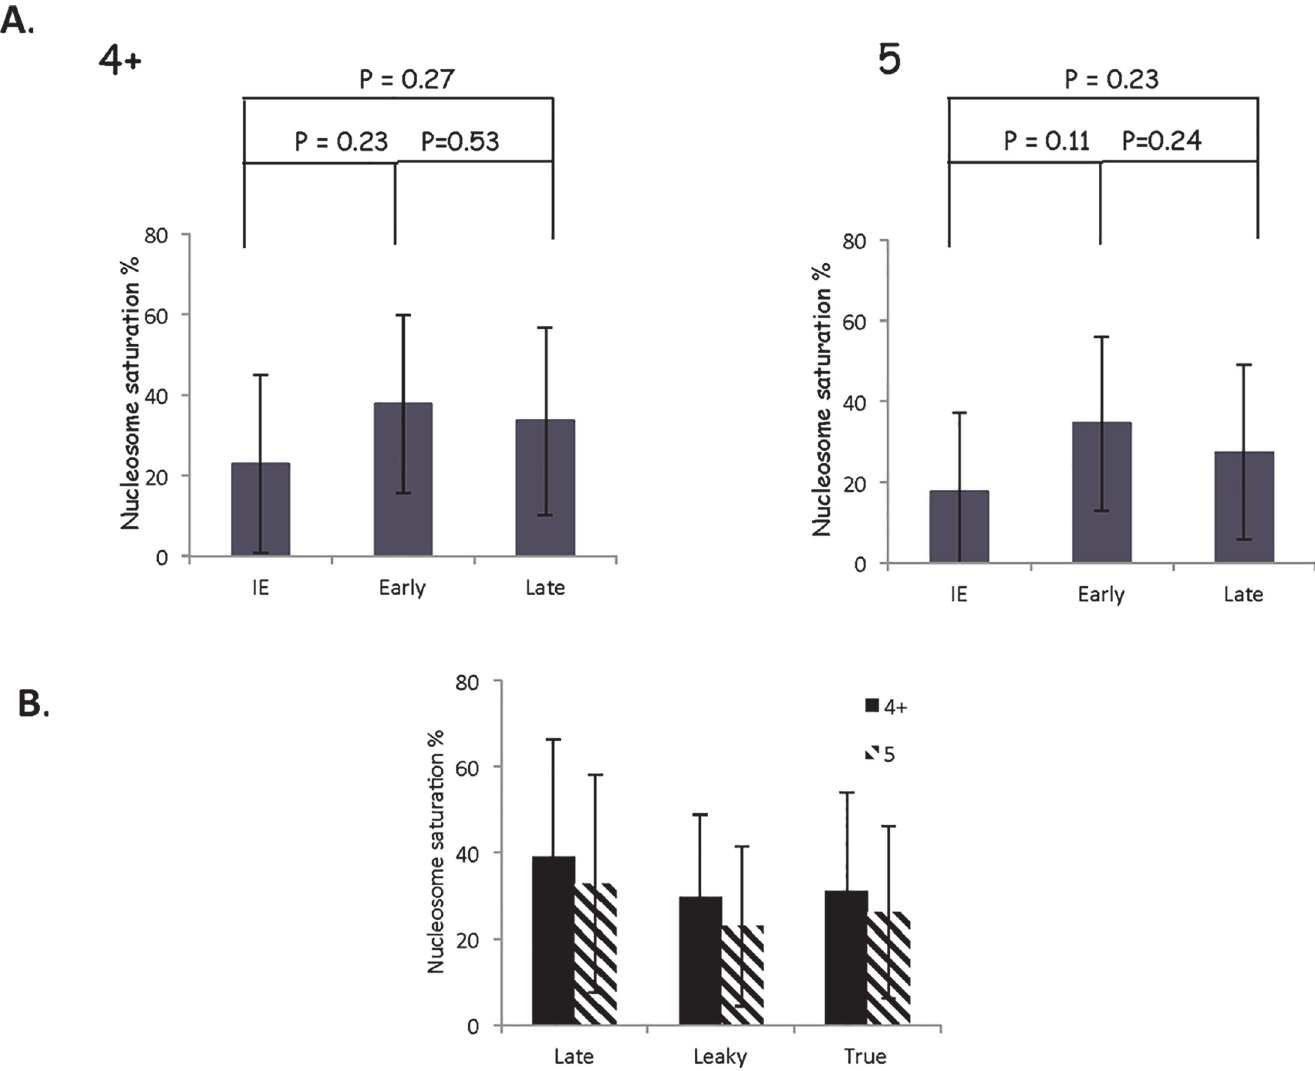
Fig 7. The nucleosome saturation on IE, E, and late genes is statistically similar. A . The predicted nucleosomes for each gene kinetic class (IE, E, L), and B . sub-class (late, leaky, true) were compared to the maximum number of nucleosomes to give the nucleosome saturation, which is expressed as a %. The average % saturation of IE genes was not significantly different than the average saturation of the E genes or that of the Late genes (57 of 66 analyzed) using a non-parametric Wilcoxon rank sum test, although the IE genes did trend lower. Error bars represents the standard